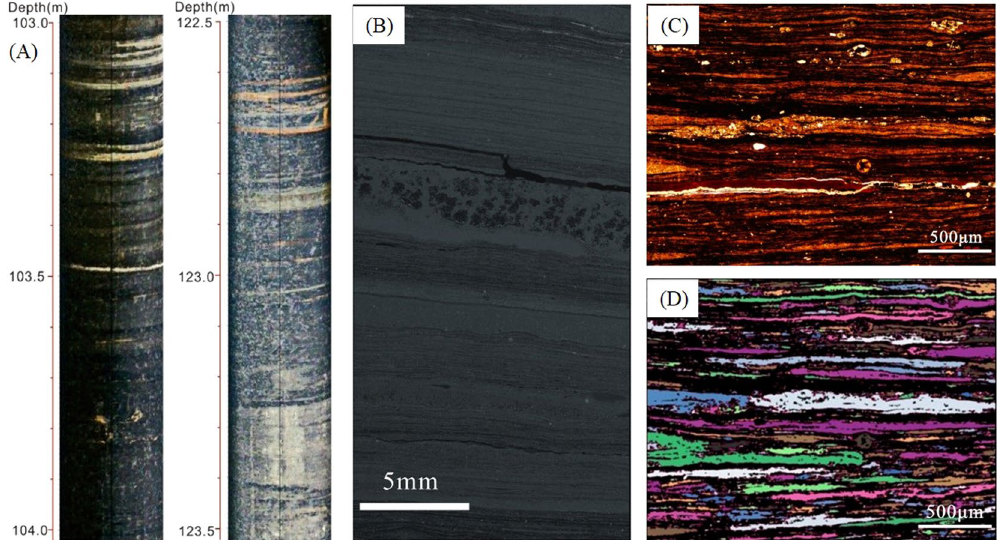
Figure 8. Stratified lamina with various measurements. ( A ) Borehole TV images, where the lamina can clearly be seen. ( B ) SEM image of internal layers in shale of the Chang 7 Member at the millimeter scale. ( C ) Thin- section photomicrographs of laminated shale, showing a variety of sandy laminas with many round apatite concretions. ( D ) Processed color image in PCAS, showing objects being extracted from the pixel